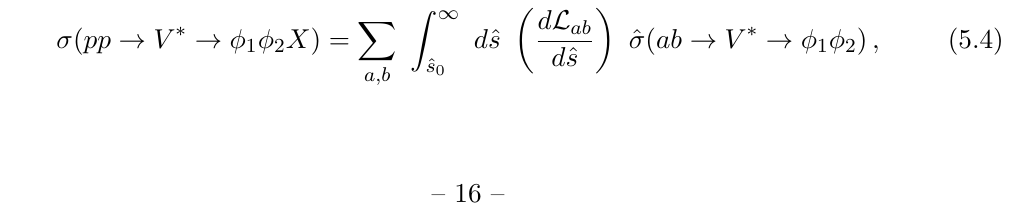
Figure 3 . The function F V (^ s; M 2 pair production (5.1),